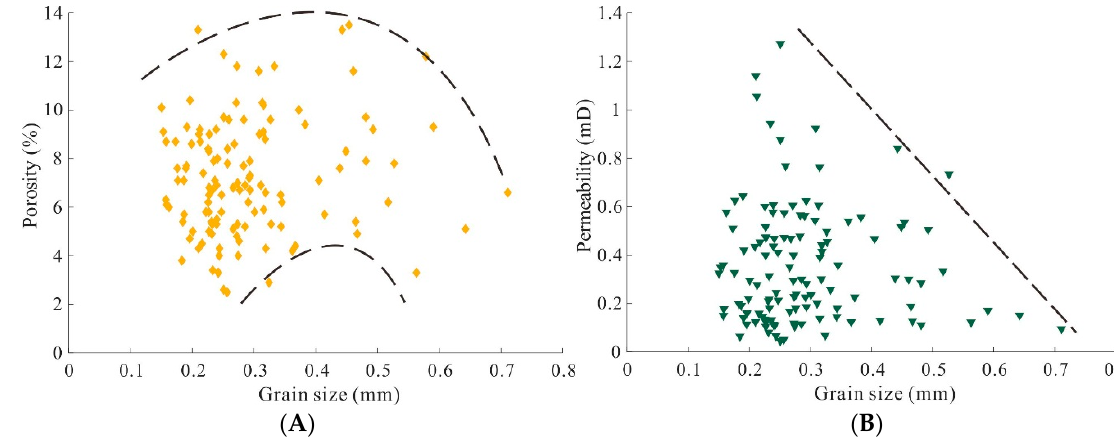
Figure 12. The relation between grain size (mm) and porosity (%) or permeability (mD). ( A ) the relation between grain size (mm) and porosity (%); ( B ) the relation between grain size (mm) and permeability (mD).